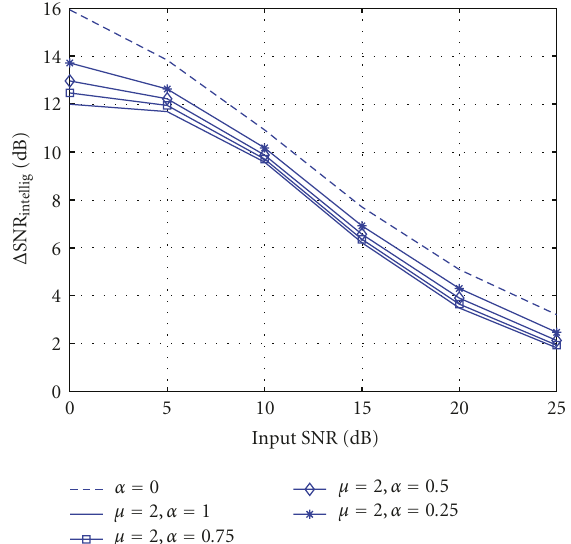
Figure 14: SNR improvement for SDW-MWF SPP ( α = 0) and SDW-MWF μ ( α = 1) with μ = 2 at di ff erent input SNRs.